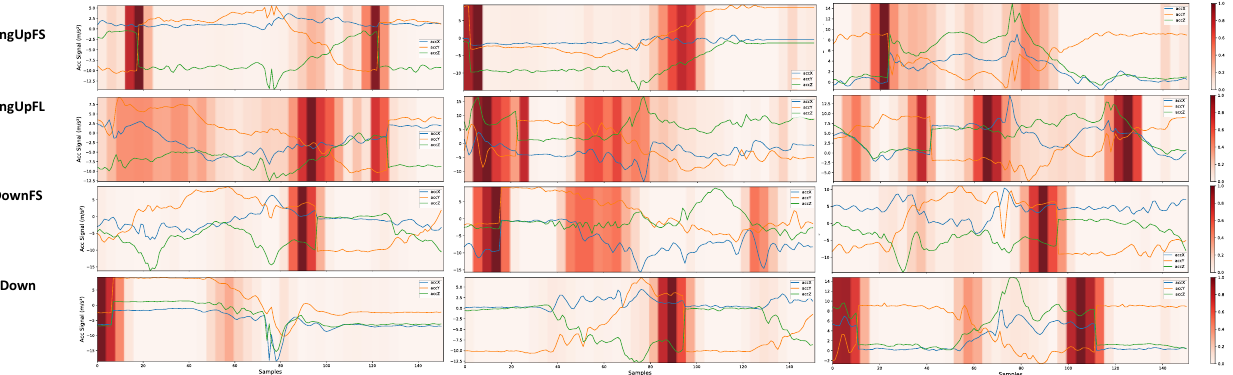
Figure 17. Possible bias problems in the dataset were identified from visual analysis of the grad-CAM in the samples. No threshold was considered for the heatmaps. We can see that the network gave too much importance to discontinuities when predicting. This will probably reflect a problem in the generalization of the